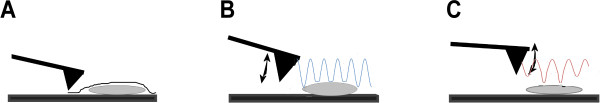
AFM imaging modes: (A) contact mode, (B) intermittent contact, (C) non-contact mode.